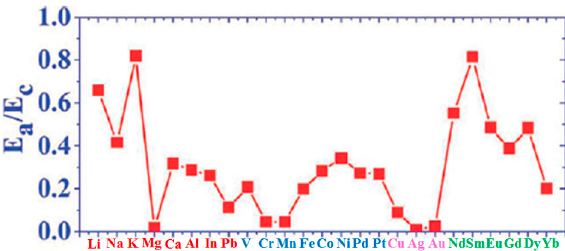
Figure 2. Ratio of adsorption energy to bulk cohesive energy for various materials calculated by Liu et al. Reproduced from Reference [100] with permission from the Royal Society of Chemistry.